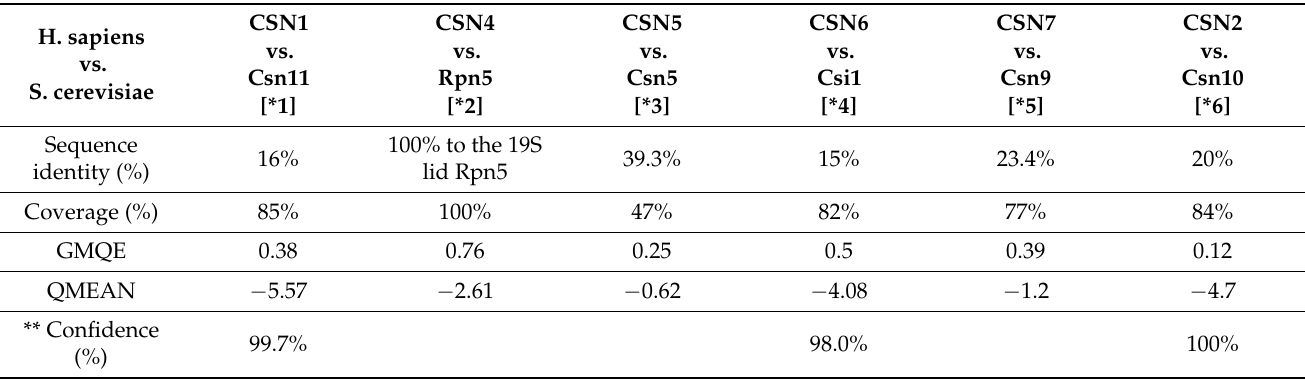
Table 1. Sequence identity between the H. sapiens and S. cerevisiae orthologues CSN subunits. H.